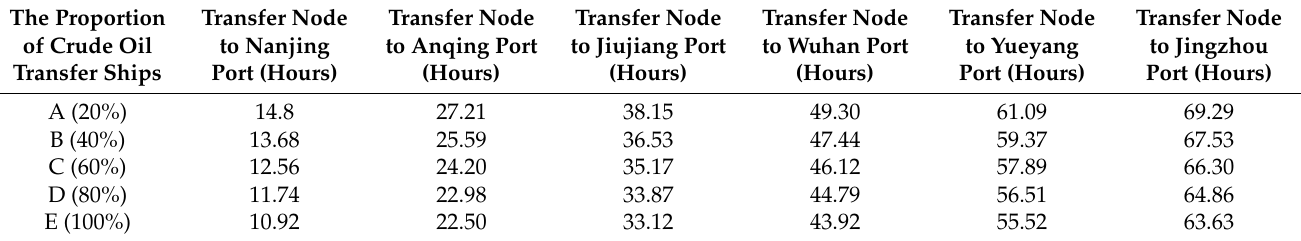
Table 3. Sailing time of the oil tanker from the transfer node to each consumption